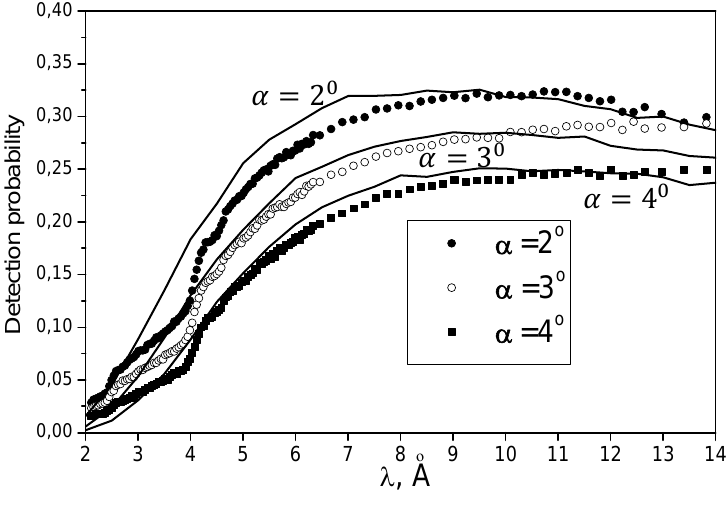
Figure 2. The probability of neutron reflection within the detector solid angle is shown as a function of the neutron wavelength; corresponding to 40–50% total probability (albedo) of quasi-elastically scattered neutrons. The incidence angle α is equal to 2°, 3°, and 4°. Dark and empty circles as well as squares correspond to measured data; solid lines illustrate